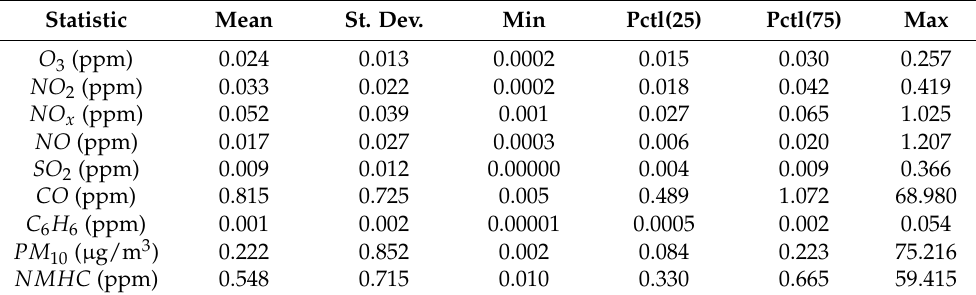
Table 1. Descriptive statistics of air pollutants in years (2012–2017) for the State of Kuwait.